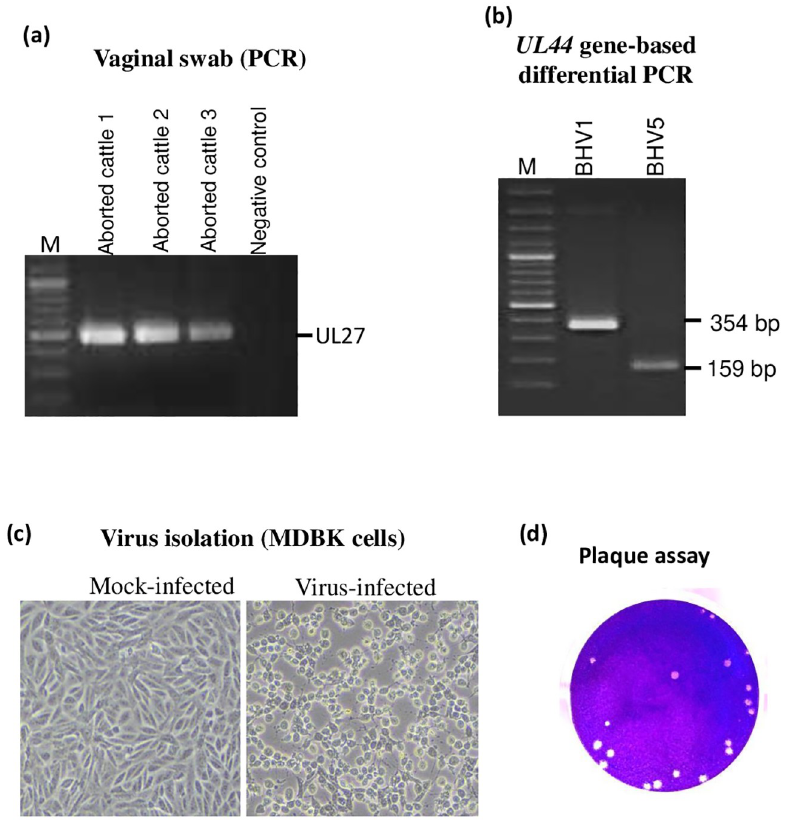
Fig 1. Isolation and identification of the agent. (a) Amplification of BoHV1 genome in vaginal swab . Virus was recovered from the vaginal swabs in DMEM followed by DNA extraction and PCR to amplify UL27 gene of BoHV1. (b) BoHV1/BoHV5 differential PCR . PCR was carried out to amplify UL44 gene as per the method described by Claus et al . PCR amplification of UL44 from BoHV1 (reference) and BoHV5 (sample) resulted in amplification of 354 bp and 159 bp fragments respectively. (c). Virus isolation in MDBK cells . Virus recovered from the vaginal swab was used to infect MDBK cells. Cytopathic effect was observed at 3 rd blind passage. Virus-infected and mock-infected cells are shown. (d) Plaque assay . Confluent monolayers of MDBK cells were infected with 10-fold serial dilutions of the